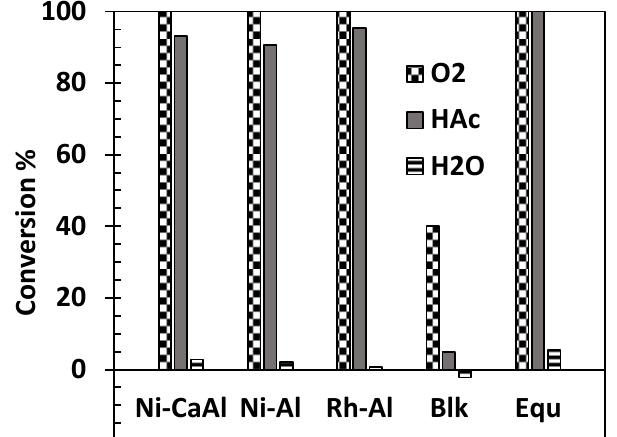
Figure 2. Conversion in % of HAc (1 mL/h), water and oxygen using 1 g Ni-Al, 1 g Ni-CaAl, 0.2 g Rh-Al catalysts, 1 g sand (Blank experiment ‘Blk’), and equilibrium (Equ) at S/C 2, reactor exit gas temperature of 570 °C, λ = 0.353 and pressure of 1 bar.